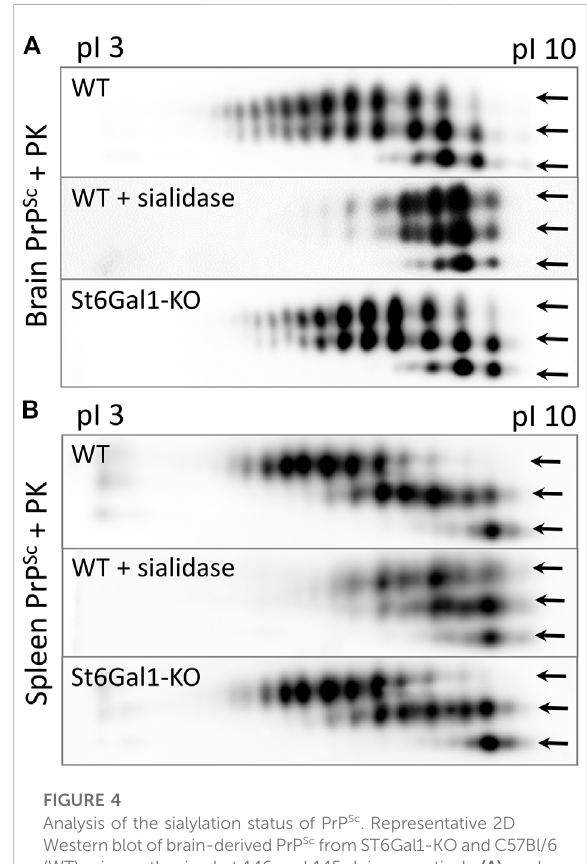
FIGURE 4 Analysis of the sialylation status of PrP Sc . Representative 2D Westernblotofbrain-derivedPrP Sc fromST6Gal1-KO andC57Bl/6 (WT) mice euthanized at 146 and 145 dpi, respectively (A) , and spleen-derived PrP Sc from ST6Gal1-KO and C57Bl/6 (WT) mice euthanized at 158 and 154 dpi, respectively (B) . Mice were inoculated IC with 1% scrapie brain homogenate of the 22L strain. Middlepanelsshowbrain-andspleen-derivedPrP Sc fromWTmice desialylated using sialidase Arthrobacter ureafaciens . Prior to 2D blot, brain and spleen materials were treated with 20 μ g/mL PK. Anti-PrP antibody ab3531 was used for immunodetection. Arrows point at di-, mono- and non-glycosylated